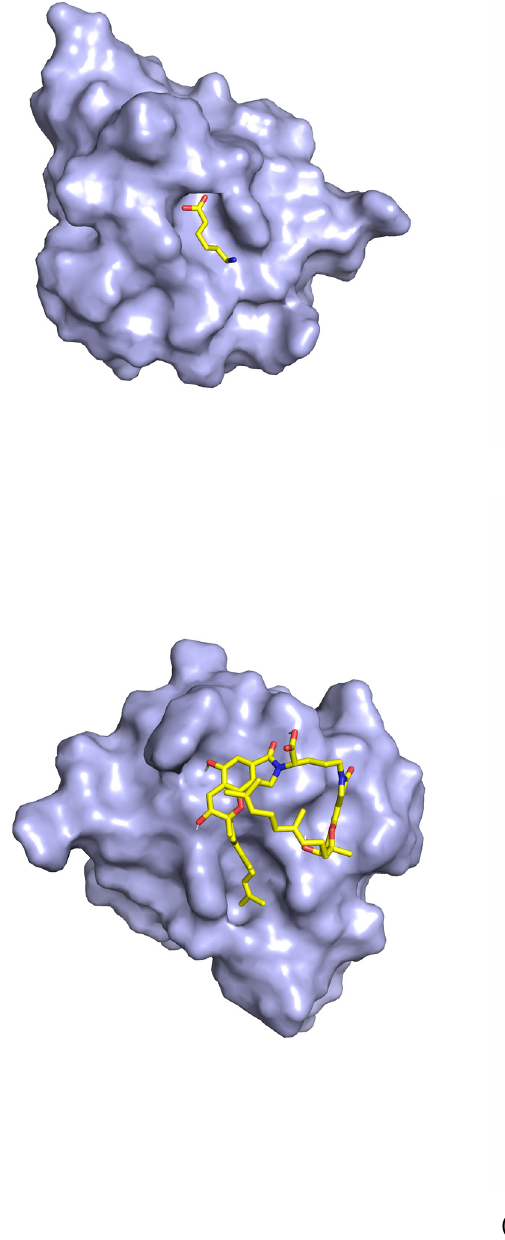
Figure 7. The docking results of ligands (EACA and FGFC1) with kringle domains (KR1–KR5) ( A – E ). In each group, the docking results of EACA (top) and FGFC1 (bottom) with KR1–KR5 are shown, along with the binding site (left) and amino acid residues involved (right). The dotted lines represent hydrogen bonds between the ligand and amino acid residues. KR1–KR5 are shown in surface representation, whereas EACA and FGFC1 are shown as